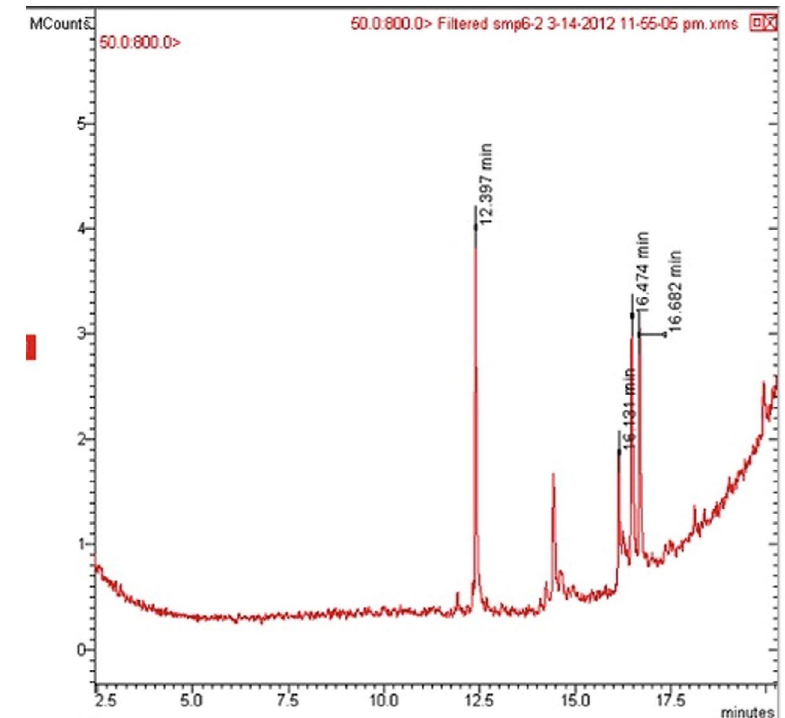
Fig. 4 . Chromatogram showingresults of the major compounds from the active